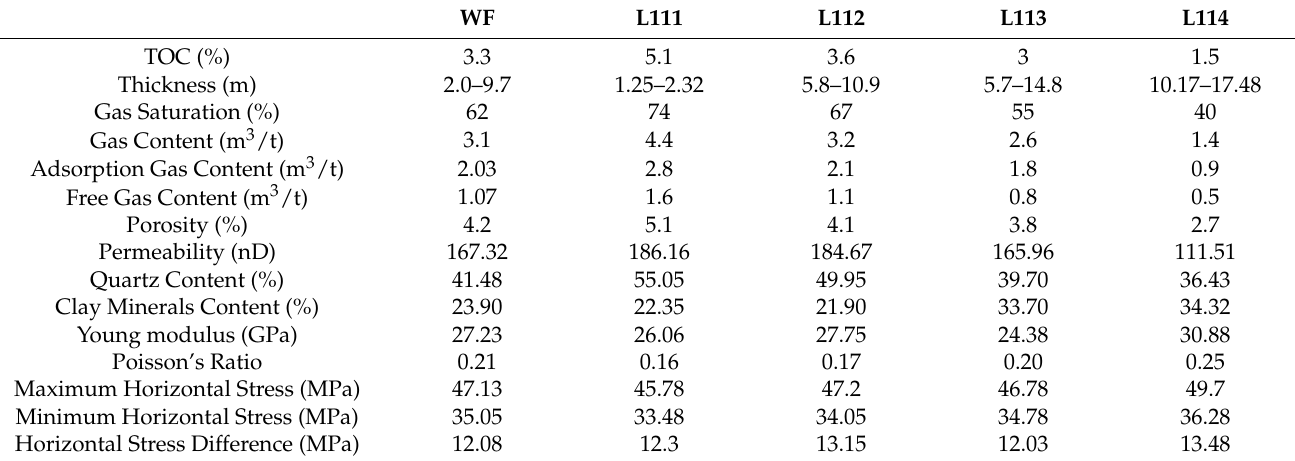
Table 2. Summary of the reservoir properties of every layers in study